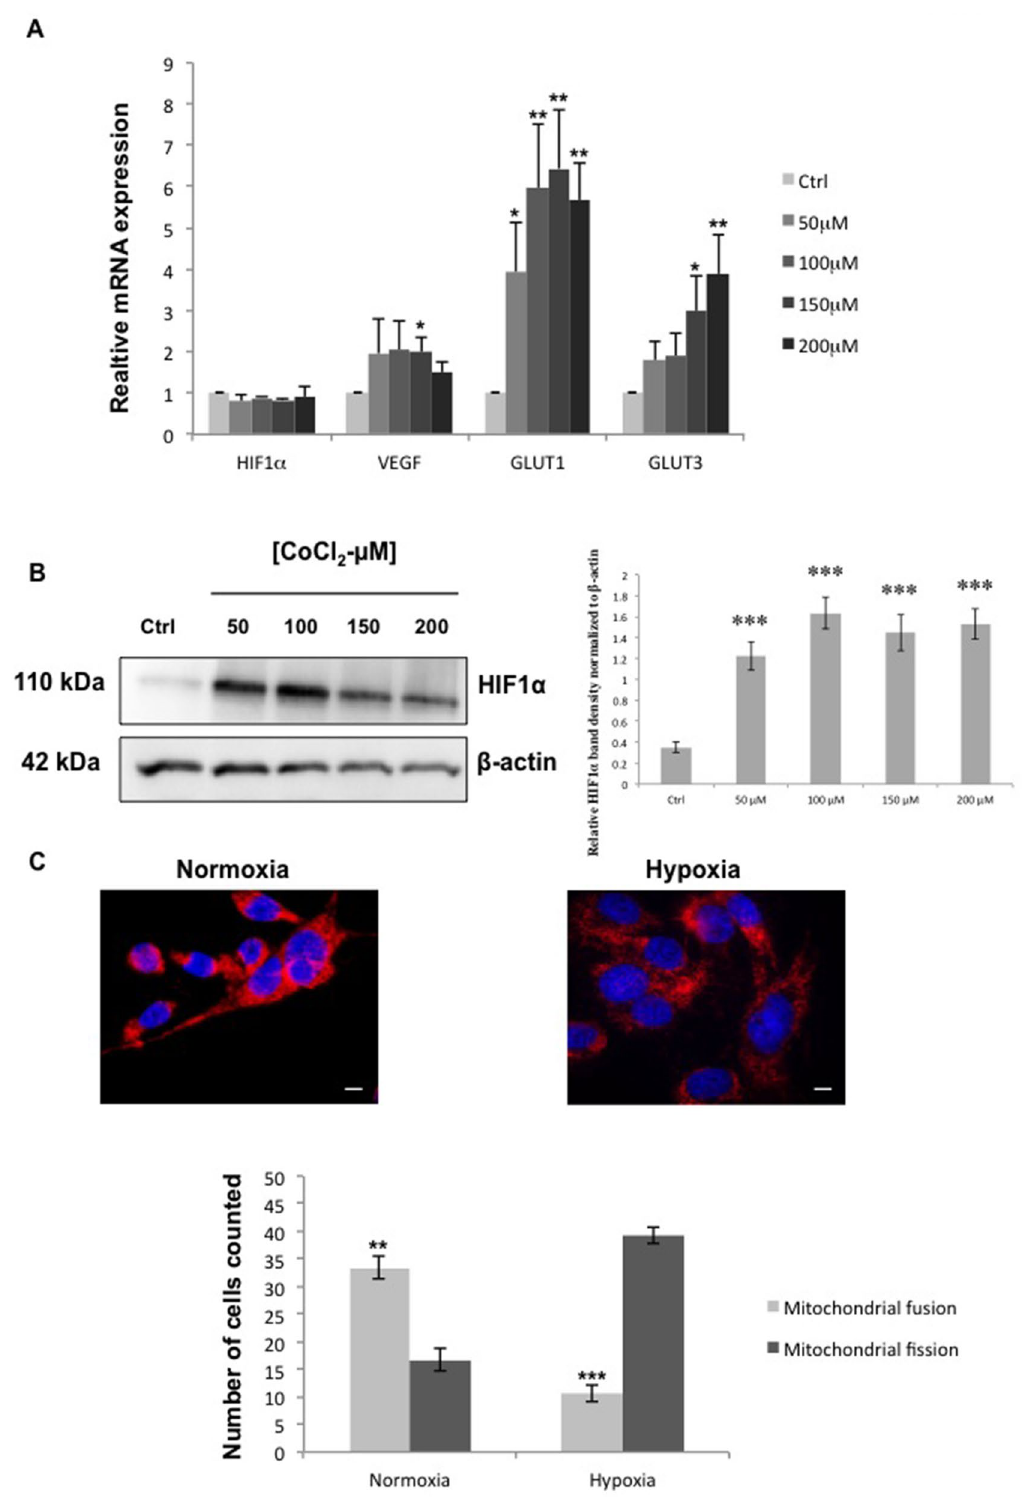
Figure 5. Characterization of the hypoxic model for glioblastoma cancer cells. ( A ) Relative mRNA expression levels of hypoxia related genes in control cells and U87-MG cells treated with different concentrations of CoCl 2 after 24 h of treatment. Quantification of mean ± SEM from 3 independent experiments, *P < 0.05, **P < 0.01 from control. ( B ) Western Blot and quantification of HIF1α protein expression in control cells and U87-MG cells treated with different concentrations of CoCl 2 after 24 h of treatment. Quantification of mean ± SEM from 3 independent experiments, ***P < 0.001 from control. ( C ) Immunofluorescence detection of Cytochrome C (red), in U87-MG cells cultured under normoxia and hypoxia. Blue staining shows the cell nucleus. The scale bar represents 50 µm. ImageJ (1.52a Version, https ://image j.nih.gov/ij/) was used to do our images. Quantification of fusioned and fissioned mitochondria inside U87-MG cells cultured under normoxia and hypoxia. 50 cells were analysed for each condition. Quantification of mean ± SEM from 3 independent experiments, **P < 0.01, ***P < 0.001 from